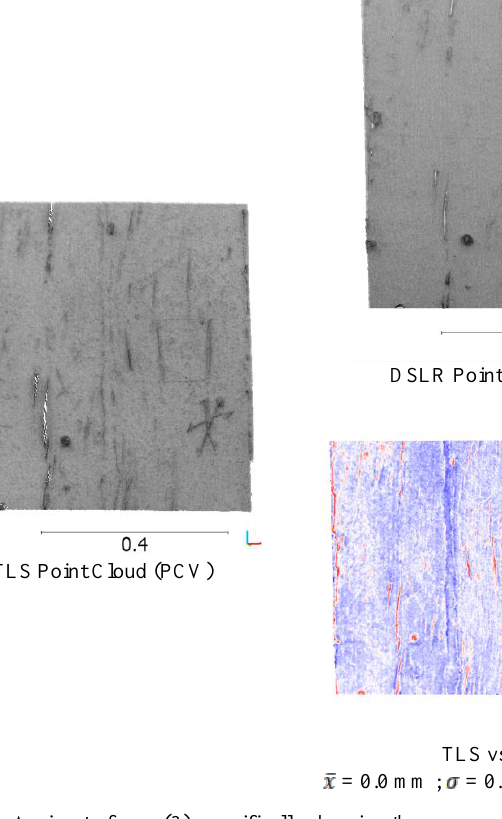
Figure 5. An inset of case (3), specifically showing the presence of engravings. The point clouds are here shown in PCV shading to highlight the engravings. Mesh-to-cloud analysis was performed using TLS Mesh as reference for the second row: denotes average deviation in 3D Euclidean distance, denotes standard